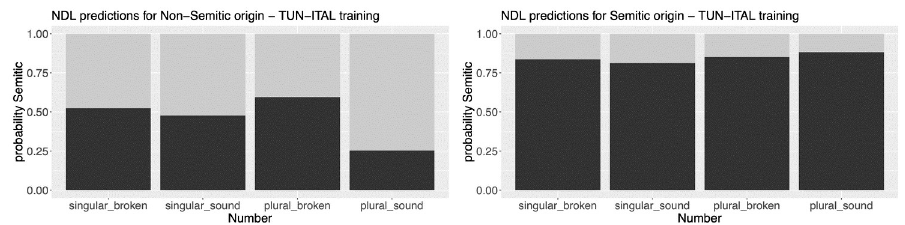
Fig 4. Classification probability (y-axis) for the Non-Semitic (left column) vs. Semitic group (right column) of Maltese nouns classified as Semitic by the Tunisian Arabic + Italian network. The x-axes show the morphological classes (singular broken vs. singular sound vs. plural broken vs. plural sound). The color coding indicates the predicted classifications of the model: dark grey = semitic , light grey = non-semitic .